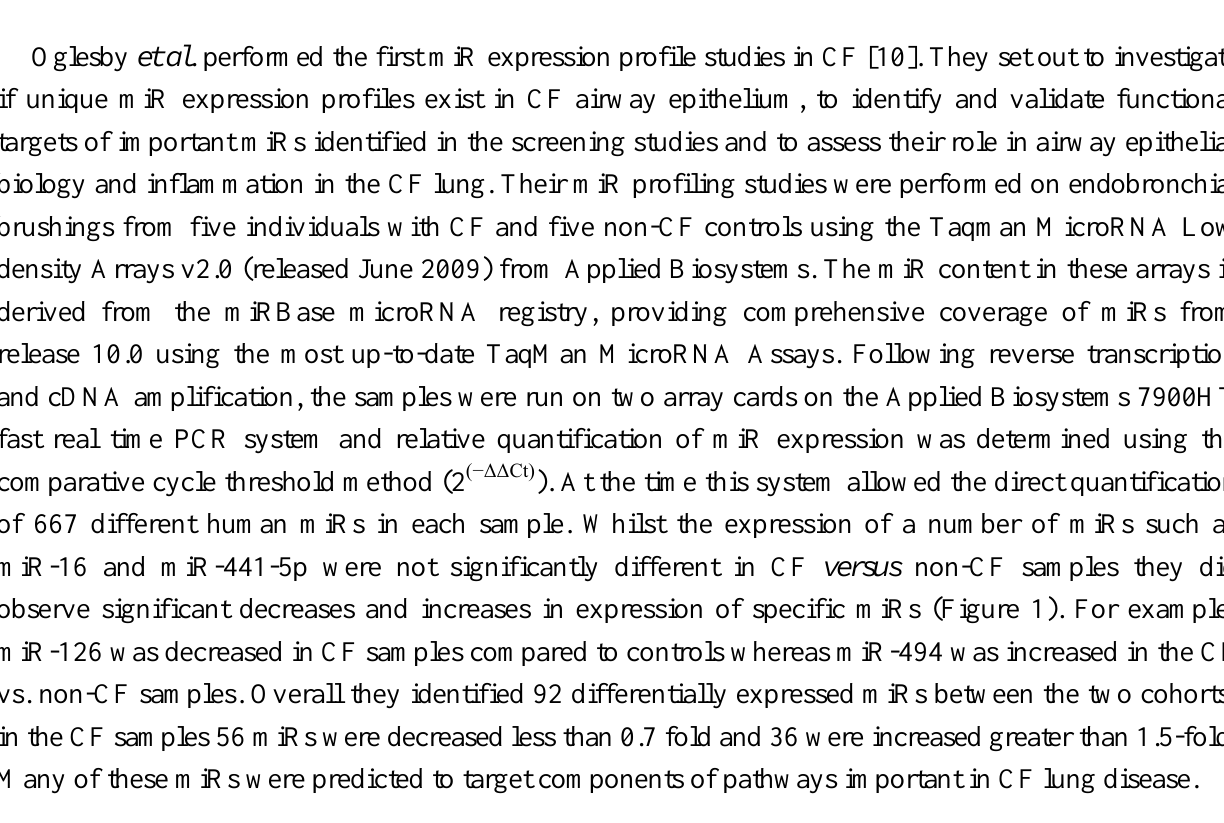
Figure 1. MicroRNAs (miR) expression in vivo . Expression levels of miR-16, miR-441- 5p, miR-126 and miR-494 in cystic fibrosis (CF) (white bars) and non-CF (black bars) bronchial brushings measured by TaqMan Low Density array (CF and control; n = 5 each). Data are represented as fold change compared to normalized controls (* p <